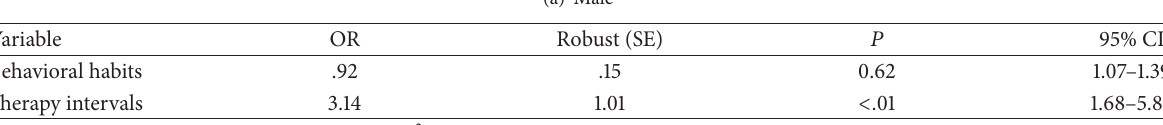
Table 5: Logistic regression model (forward stepwise procedure) for BRONJ presence, stratified for